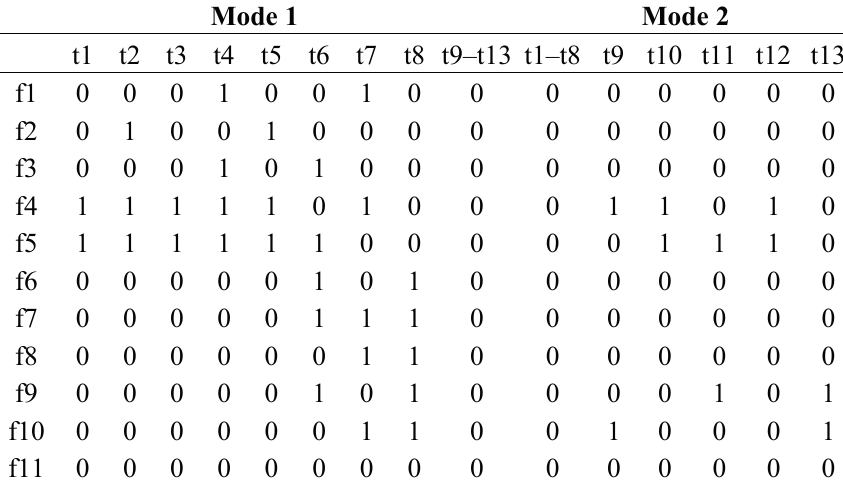
Table 7. D-matrix of the real world